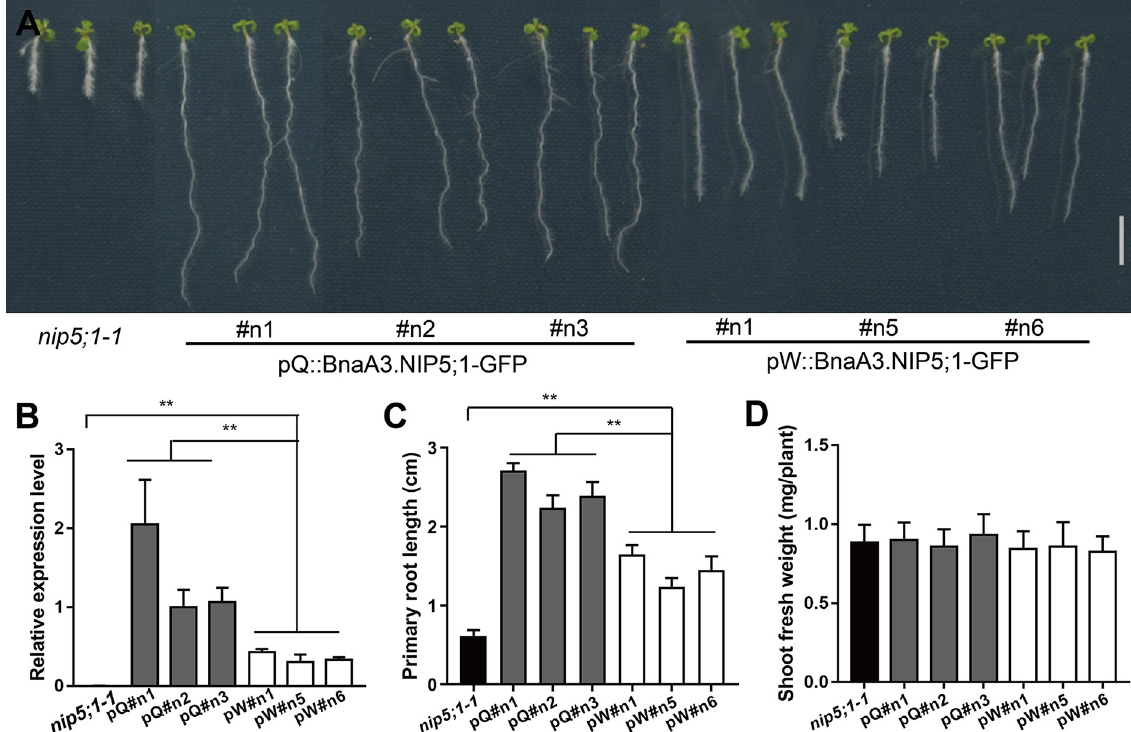
Fig 4. BnaA3 . NIP5;1 promotes Arabidopsis root growth. ( A ) Phenotype of 10-d-old nip5;1–1 , pQ::BnaA3.NIP5;1-GFP#n (pQ#n) and pW:: BnaA3.NIP5;1-GFP#n (pW#n) transgenic plants under 0.3 μ M B conditions. Scale bar, 1 cm. ( B-D ) Relative expression level of BnaA3 . NIP5;1 ( B ), primary root length ( C ) and shoot fresh weight ( D ) of nip5;1–1 , pQ::BnaA3.NIP5;1-GFP#n and pW::BnaA3.NIP5;1-GFP#n transgenic plants grown under 0.3 μ M B conditions. The data presented are mean values with s.d. Three replicates in ( B ), twelve replicates in ( C ), and six replicates in ( D ). �� P < 0.01 (Student’s t